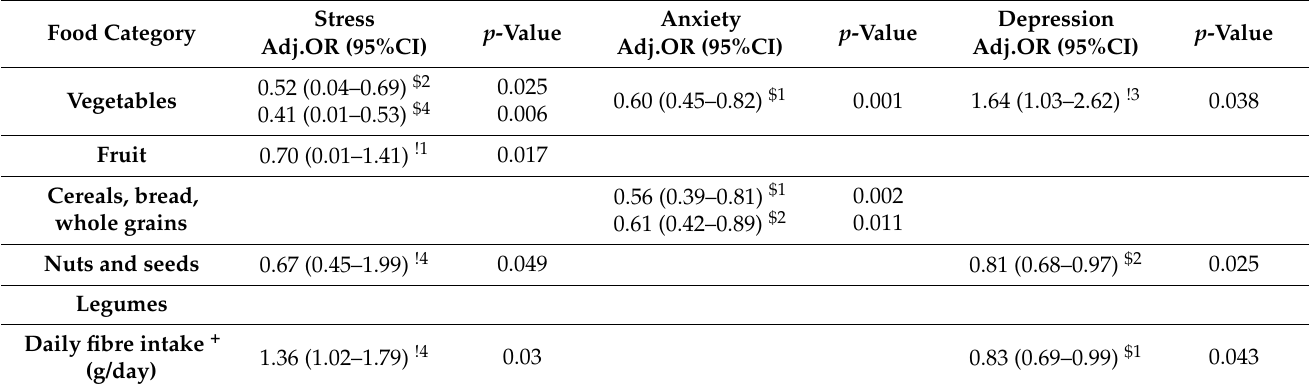
Table 3. Logistic regression analysis for significant relationship between fibre-rich food consumption and mood status among